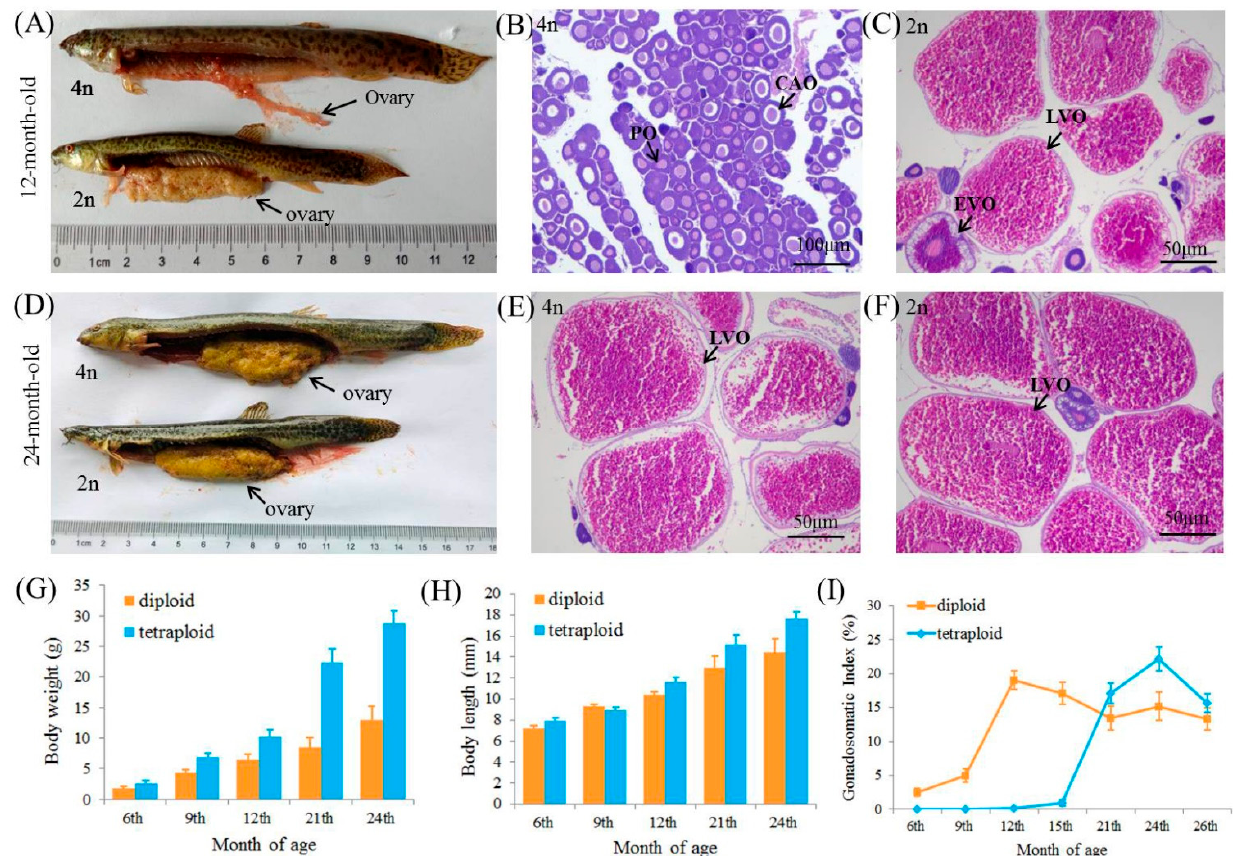
Figure 1. The ovarian development and body growth traits of tetraploid and diploid M. anguillicaudatus . ( A , D ) display ovarian appearance difference at 12 and 24 months old; ( B , C , E , F ) display ovarian histological difference at 12 and 24 months old; ( G , H , I ) display body weight, body length and gonadosomatic index difference between diploids and tetraploids in two-year culture experiments. PO, perinucleolar oocyte; CAO, cortical-alveolar oocyte, EVO, early vitellogenic oocyte; LVO, late/mature vitellogenic oocyte.